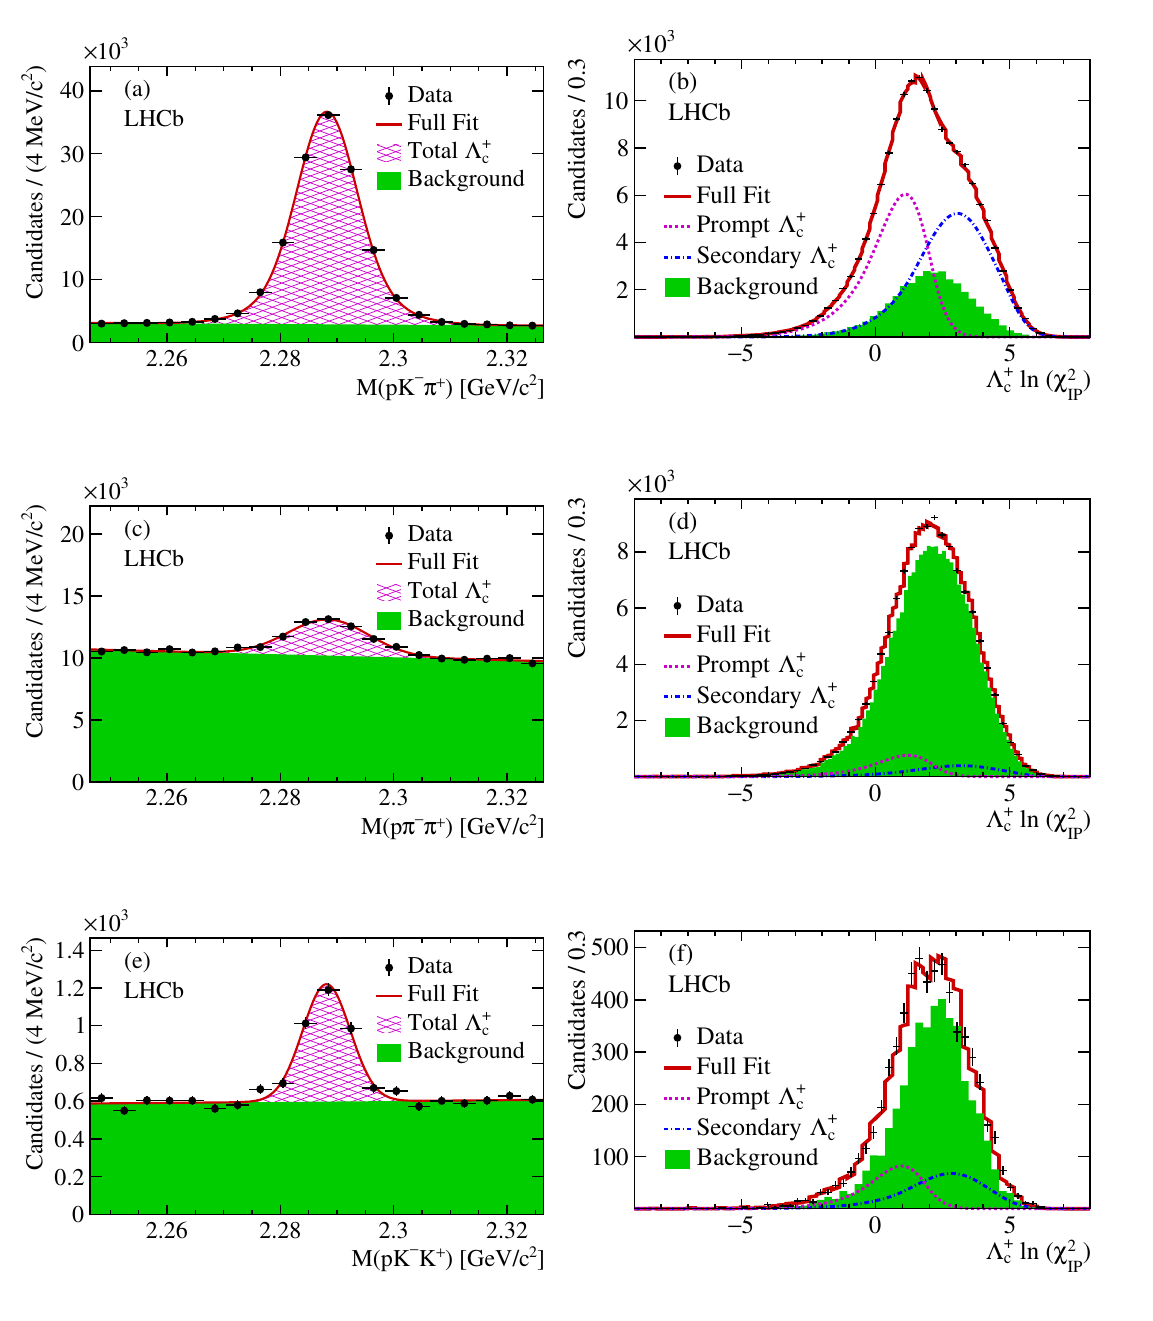
Figure 3 . Invariant mass distributions for (a) (cid:3) + in the prompt analysis, with (cid:12)t results superimposed. The ln pK (cid:0) (cid:25) + , (d) (cid:3) + ! p(cid:25) (cid:0) (cid:25) + , (f) (cid:3) + c di(cid:11)erentiation of prompt and secondary (cid:3) +